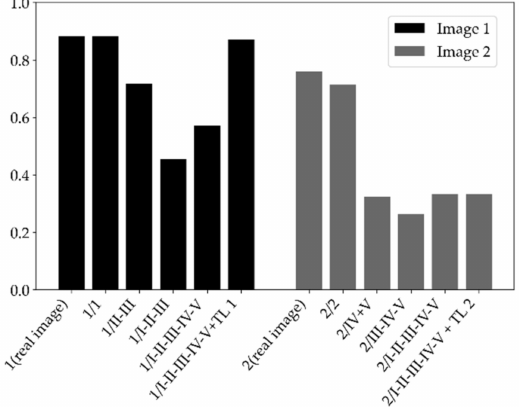
Figure 12. F1-scores achieved in the sematic segmentation for the testing images (1 and 2) in the real and synthetic images generated with proposed approach with λ MLP = 300, but generated with models trained in different sets of